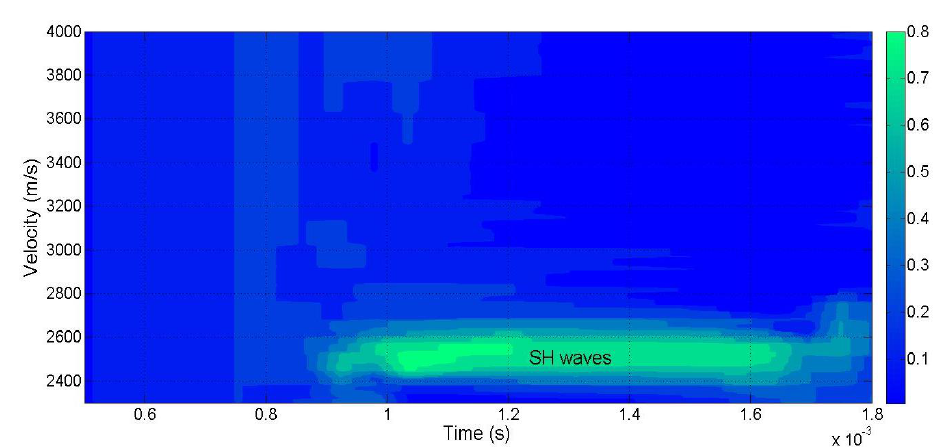
Figure 9. Time-velocity coherence diagram of the acoustic field array signal.